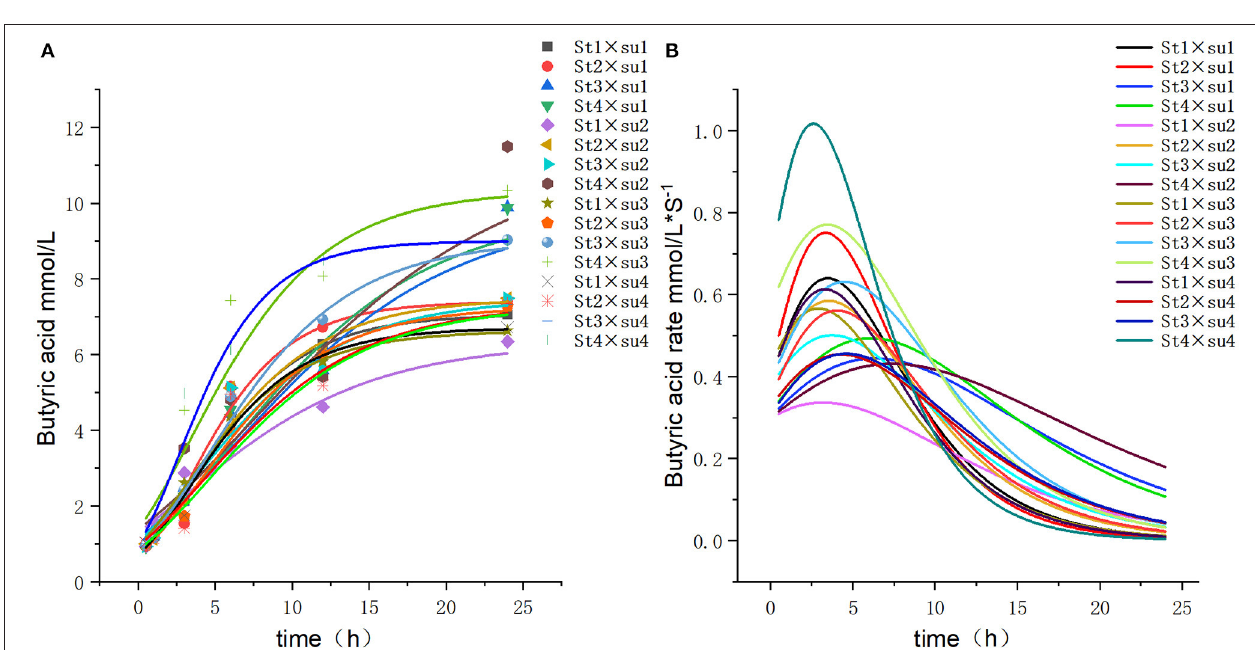
FIGURE 6 | Fitting model curve of butyric acid production. (A) Gompertz model fitting curve. (B) Derivative of Gompertz.